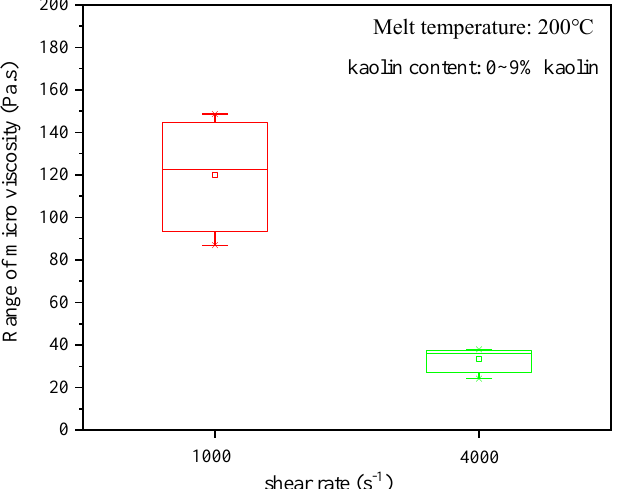
Figure 10. Effect of kaolin content on the microviscosity in the form of standard deviation.